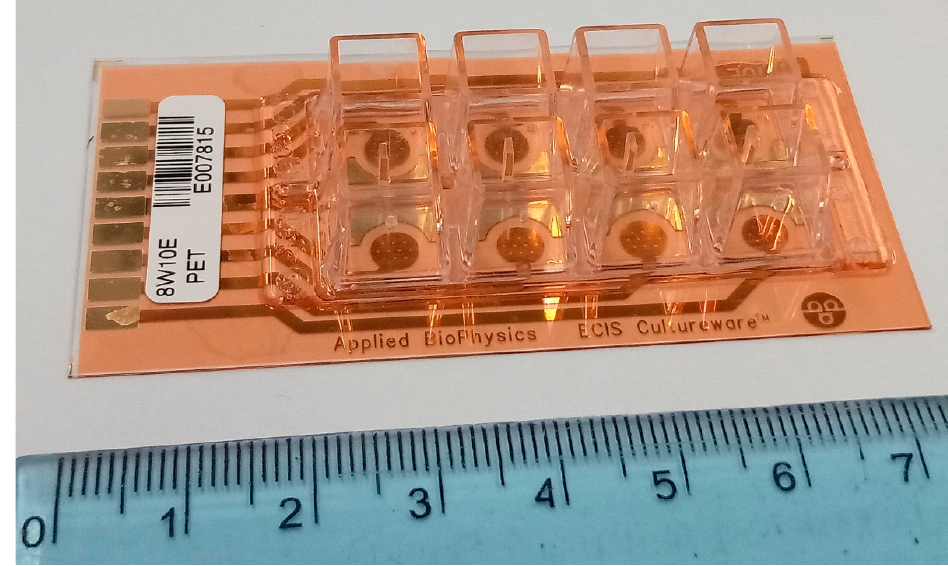
Figure 1. In vitro cell culture medium with electrodes and wells used in the ECIS measurement system.